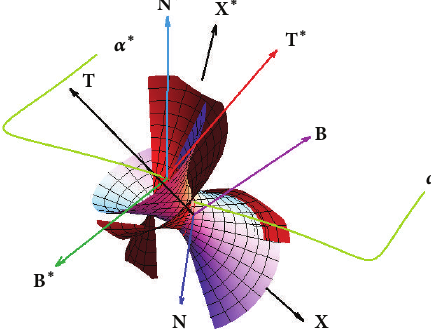
Figure 1: The original pair ( X , X ∗ ) , B U B ∗ , 𝑡 = 0 , 𝜓 = 1 , 𝑠 ∈ [−𝜋,𝜋] , V ∈ [−6,6] .